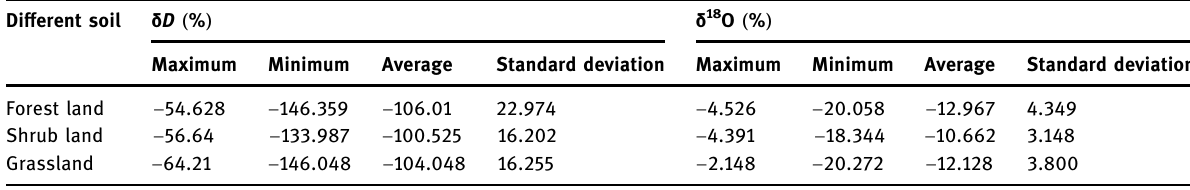
Table 2: Statistical characteristics of isotopes ratio in soil water of di ff erent soils Di ff erent